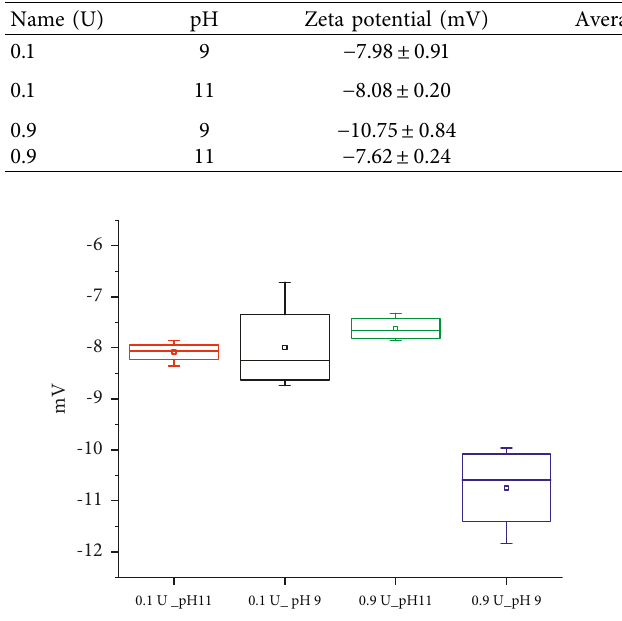
Figure 6: Zeta potential of Ag NPs obtained under 0.1 g or 0.9g of U. maydis at pH 9 and pH 11 after 100 s of sunlight exposure at room